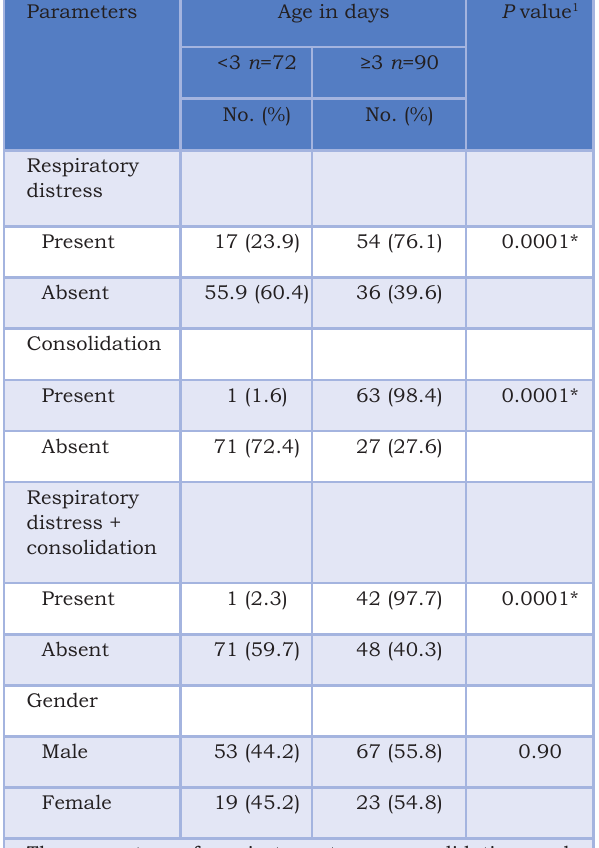
Table 1: Clinical and radiological factors in patients of esophageal atresia in relation to the age at presentation